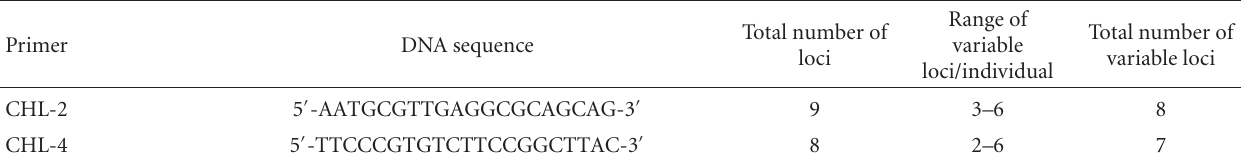
Table 4: Random primers investigated, their sequence, numbers of RAPD loci identified, range of RAPD loci per individual and numbers of variable loci. Primer DNA